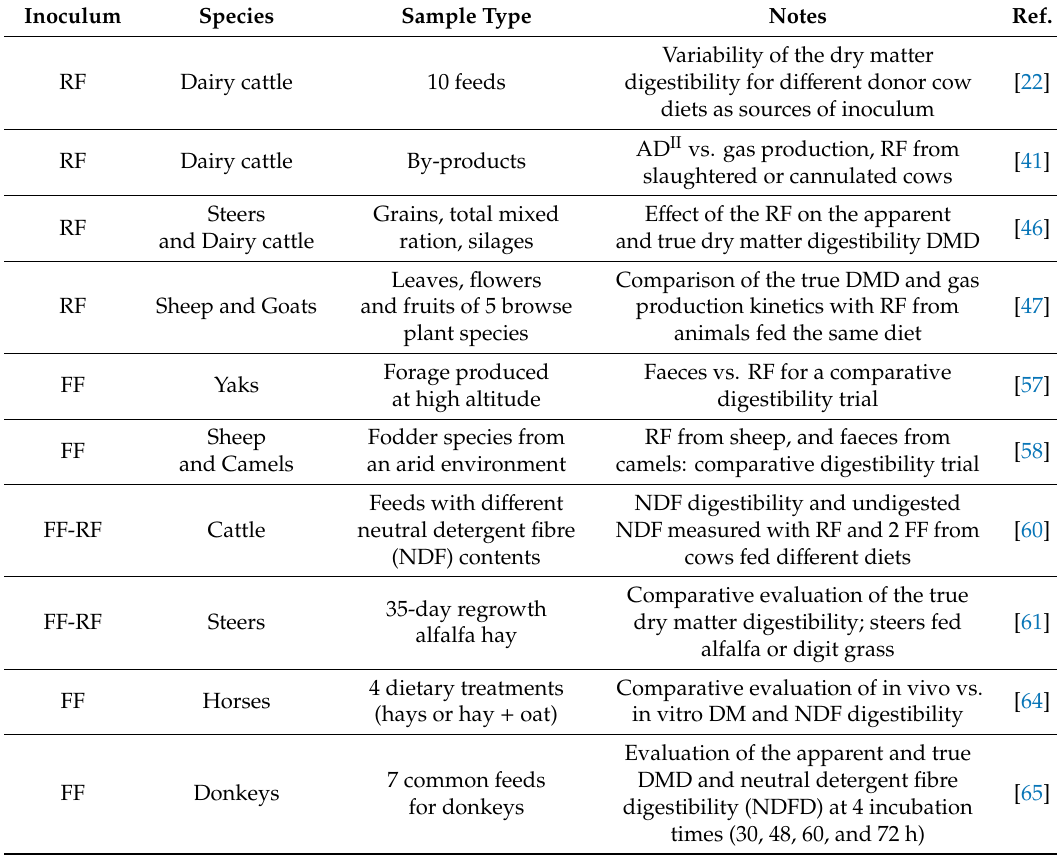
Table 1. Rumen fluid (RF) and fresh faeces (FF) inocula applied to the Ankom Daisy II incubator (AD II